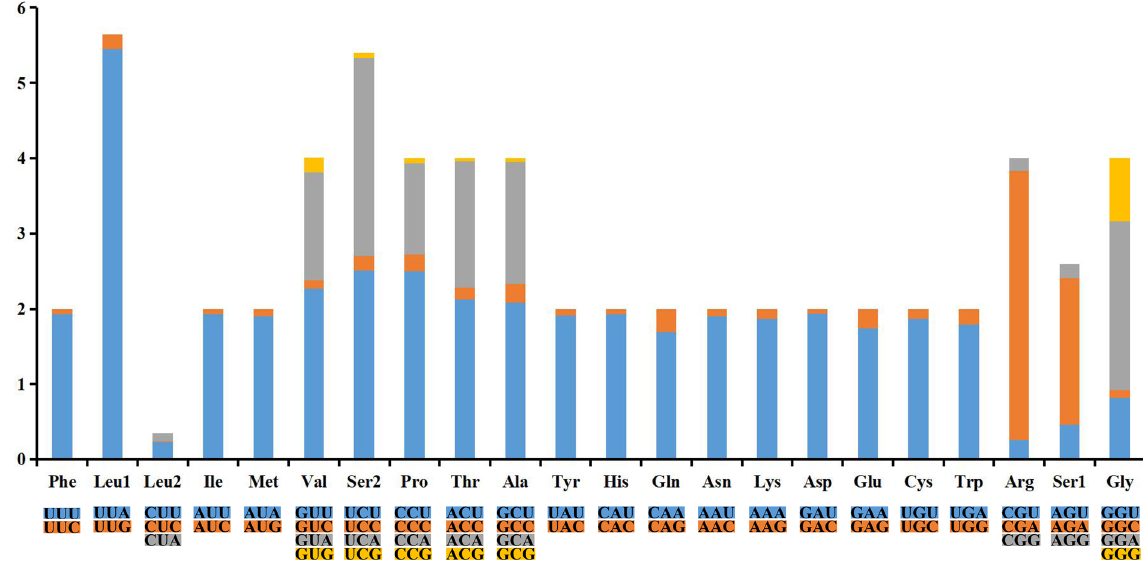
Figure 2. Relative synonymous codon usage of PCGs in the Anastatus fulloi